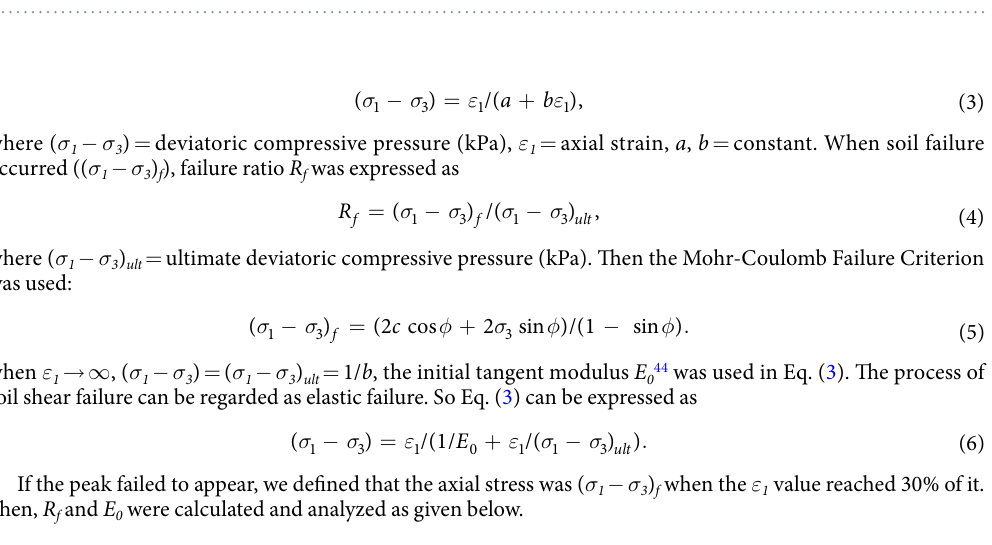
Figure 7. Geometric profile of vegetated slopes. Lateral ( a ) and aerial views ( b ) of slope are